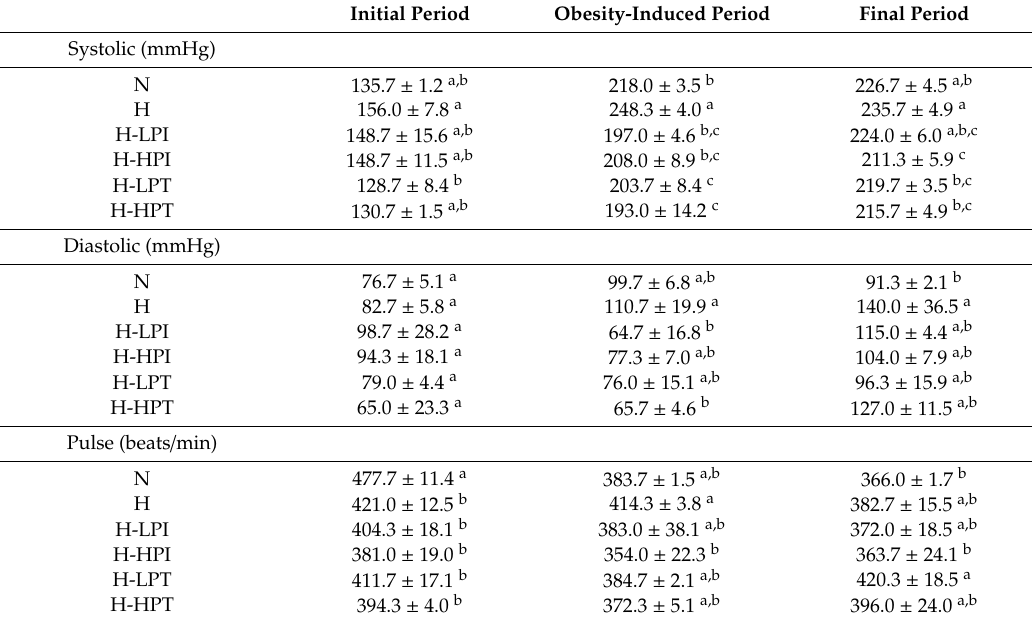
Table 5. E ff ect of patchouli essential oil on the systolic blood pressure, diastolic blood pressure, and